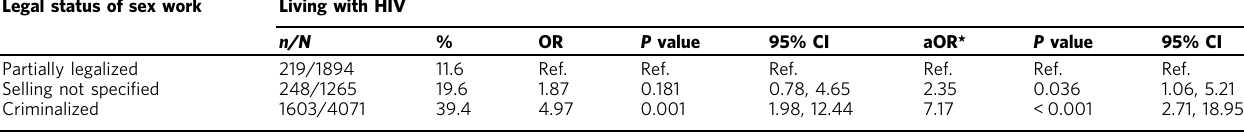
Table 4 HIV infection and country-level legal status.